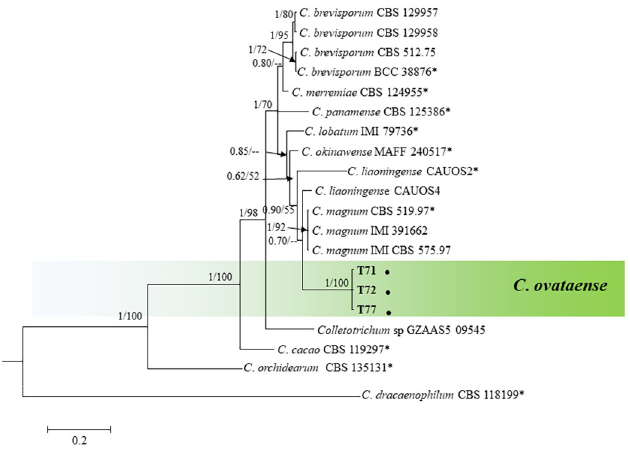
Fig 6. A Bayesian inference phylogenetic tree (50% majority consensus) of 31 isolates in the C . magnum species complex. The tree was constructed using a concatenated data set of ITS, ACT , TUB2 , and GAPDH sequences. Bayesian posterior probability (PP � 0.50) and maximum likelihood bootstrap support values (ML � 50) are shown at the nodes. The isolates collected in this study are indicated in bold. � Indicates the ex-type strains. Coloured blocks indicate clades containing isolates from Atractylodes ovata in this study. The scale bar indicates 0.2 expected changes per site. Colletotrichum orchidearum (CBS 135131) and C . dracaenophilum (CBS 118199) were used as out-group.